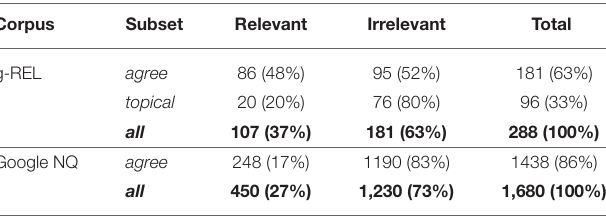
TABLE 2 | Number of samples in our dataset per corpus and